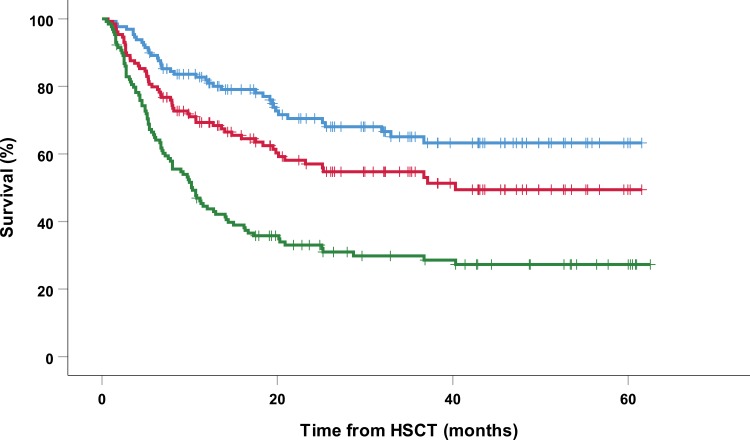
Overall survival, relapse-free, and GvHD/relapse-free survival in the total cohort.Kaplan-Meier curves for OS (blue), RFS (red) and GRFS (green) are shown for the entire cohort of 129 patients who received Flu-TBI‒based non-myeloablative conditioning prior to HCT.